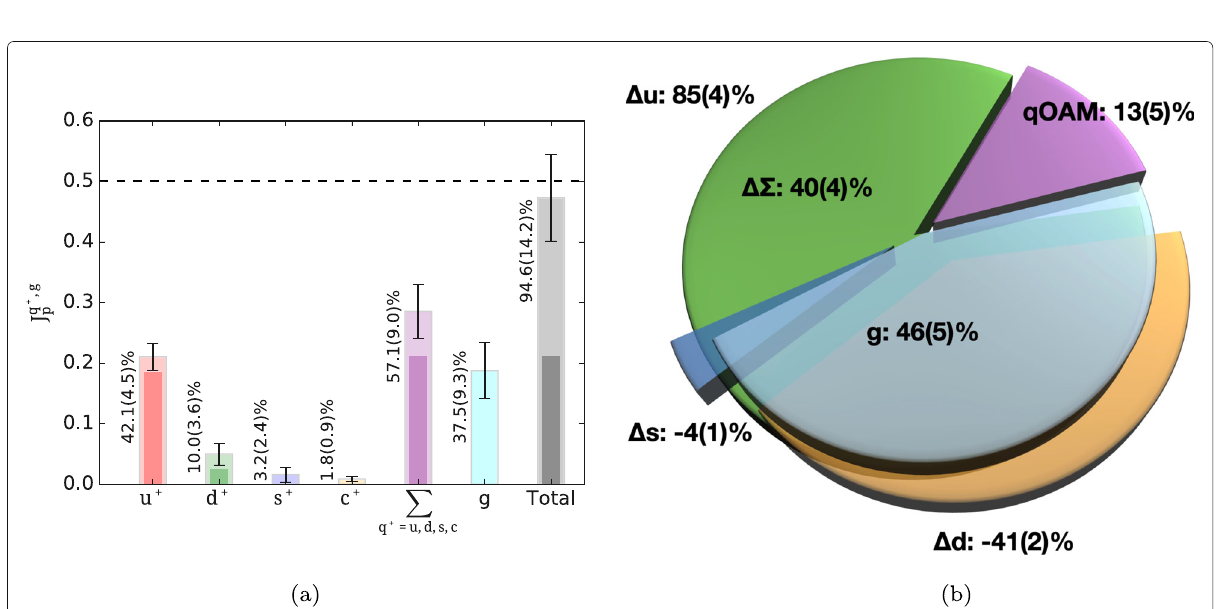
Fig. 3 a Proton spin decomposition in terms of the angular momentum J q for the u , d and s quarks and the glue angular momentum J g in Ji’s decomposition in the n f = 2 + 1 + 1 calculation [74]. b Spin decomposition in terms of the quark spin (cid:2)(cid:3) and its flavor contributions (cid:2) u , (cid:2) d and = 2 + 1 case (cid:2) s , the glue J g , and the quark OAM for the n f